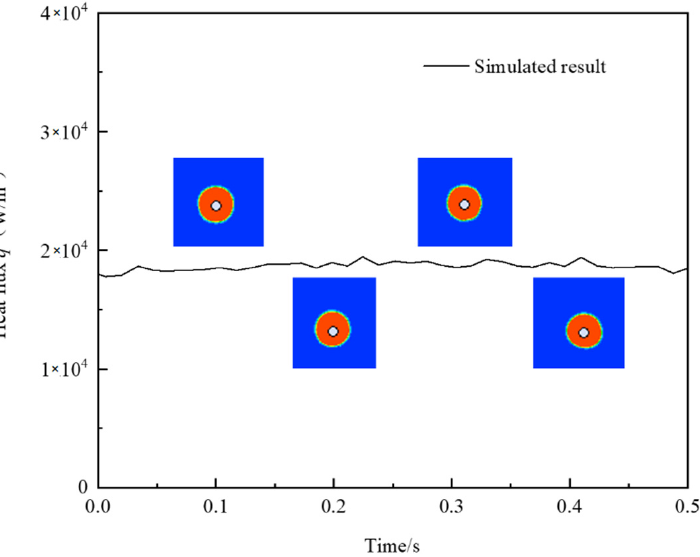
Figure 10. The spatial-averaged heat flux and the evolution of the gas–liquid interface for the 0.2 mm wire.